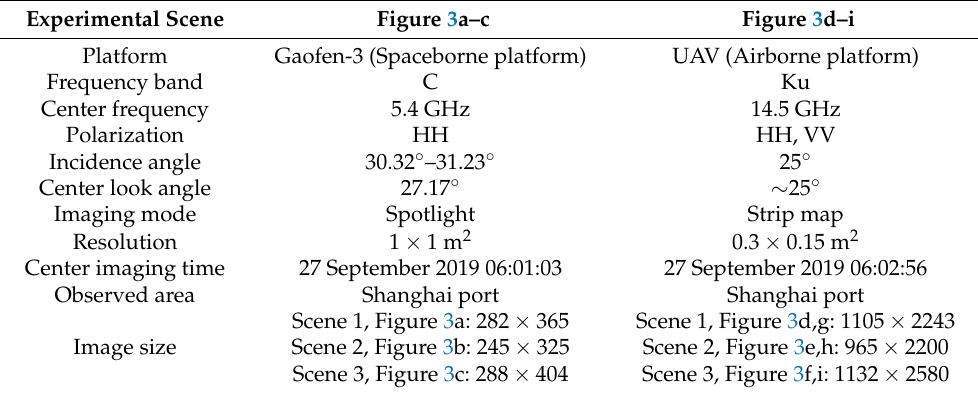
Table 1. Specifications of spaceborne and airborne SAR